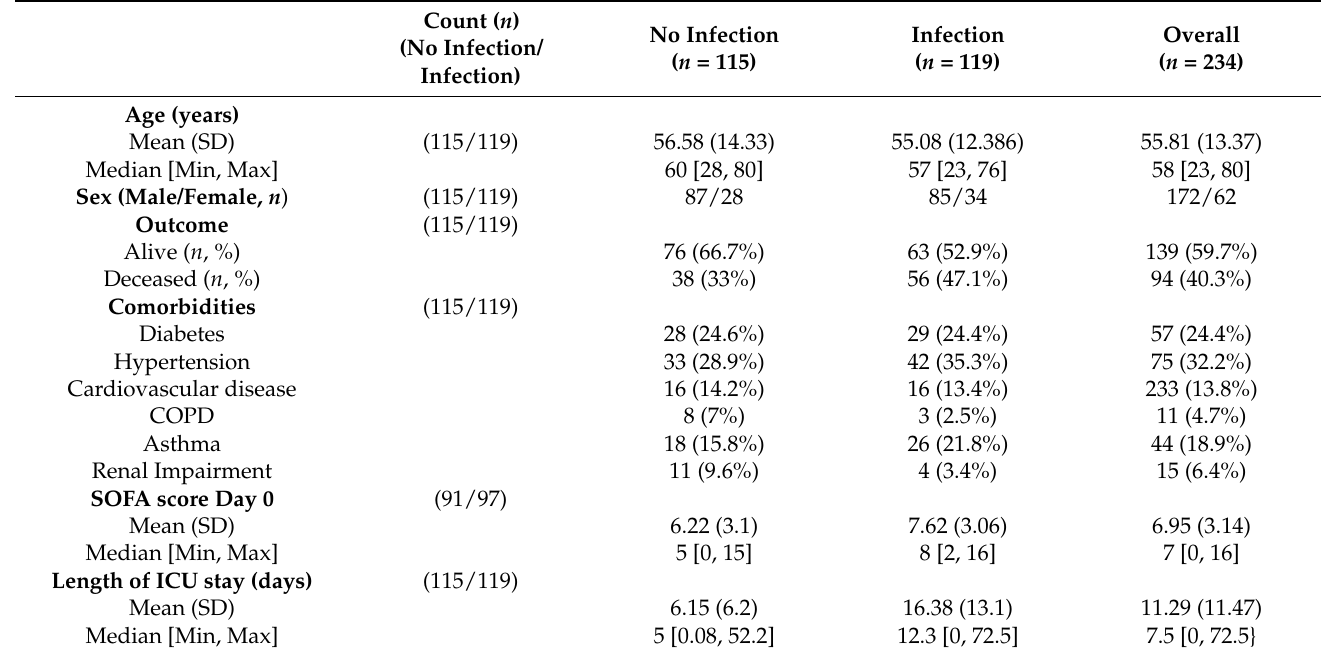
Table 1. Comparison of Patient Demographics, Comorbidities, SOFA Scores, Length of Stay in ICU, and Mortality between those who had an infection and those who did not.